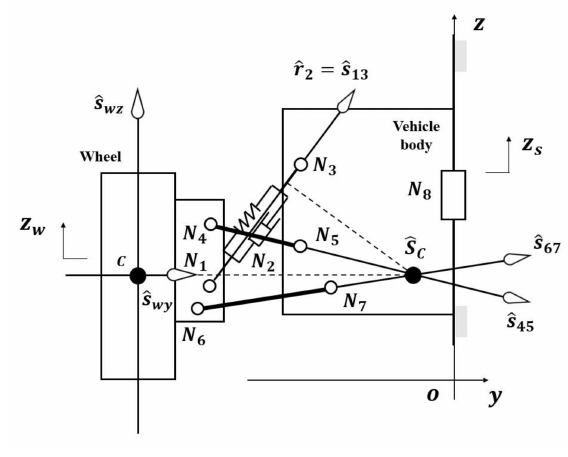
Figure 5. Instantaneous screws acting on a quarter-vehicle